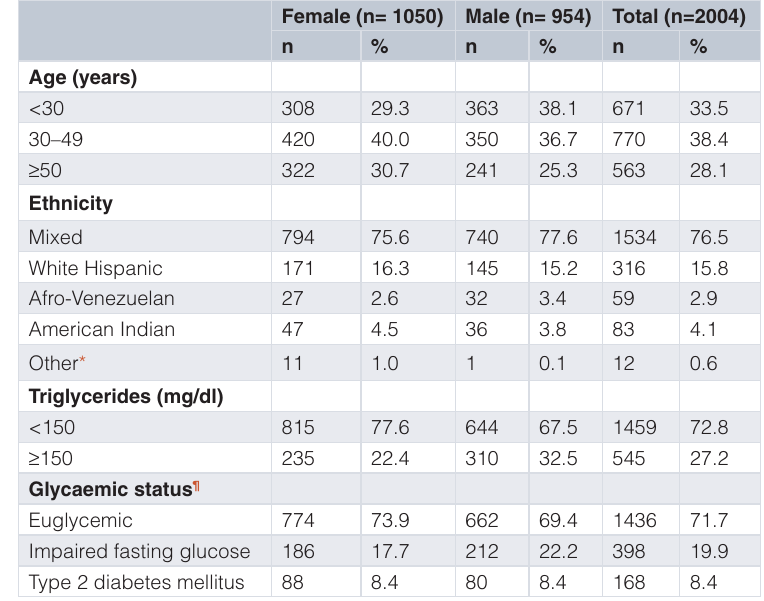
Table 1. General characteristics of the sample studied, Maracaibo city,